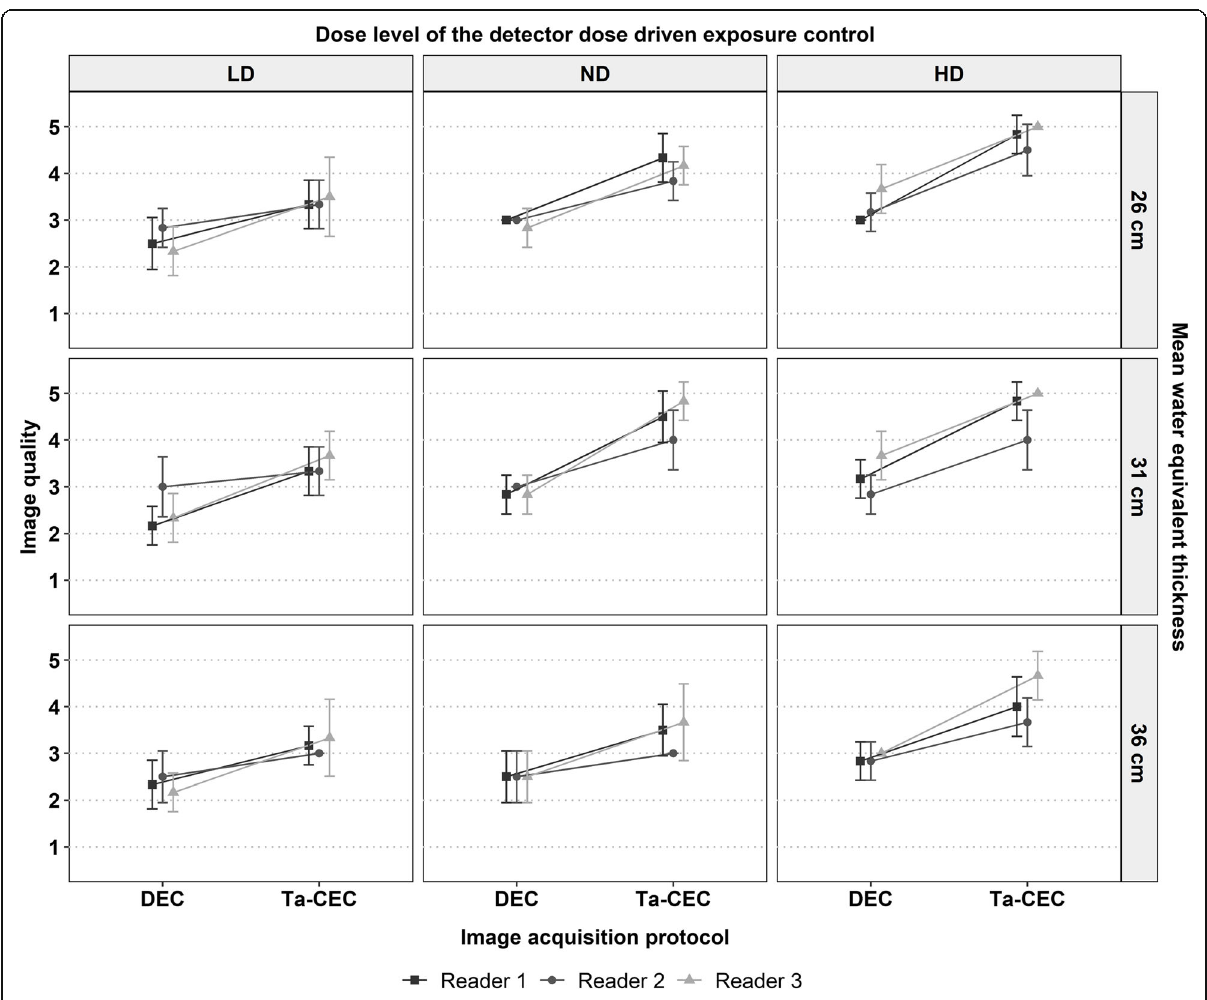
Fig. 3 Average image quality ratings of the three readers for the detector dose-driven exposure control (DEC) and the dose equivalent Ta image acquired with the contrast-to-noise ratio driven exposure control (Ta-CEC), dependent on the dose level of the detector dose-driven exposure control and the water equivalent